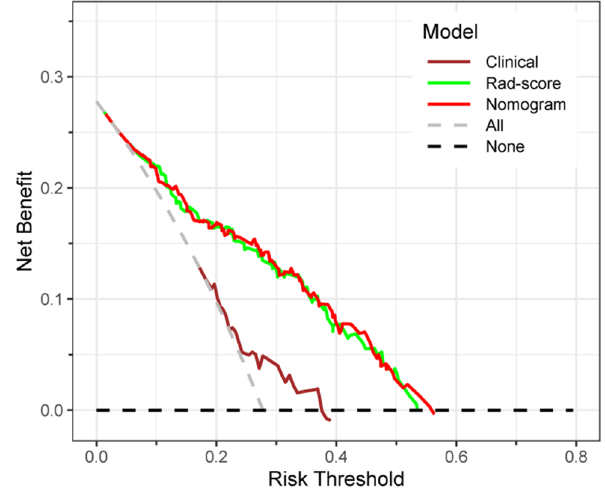
Figure 12. Decision curves of the models. If the risk threshold is less than 56.9%, the nomogram model will obtain more benefit than all treatment (assuming all breast cancer patients were HER2+) or no treatment (assuming all breast cancer patients were HER2 − ).